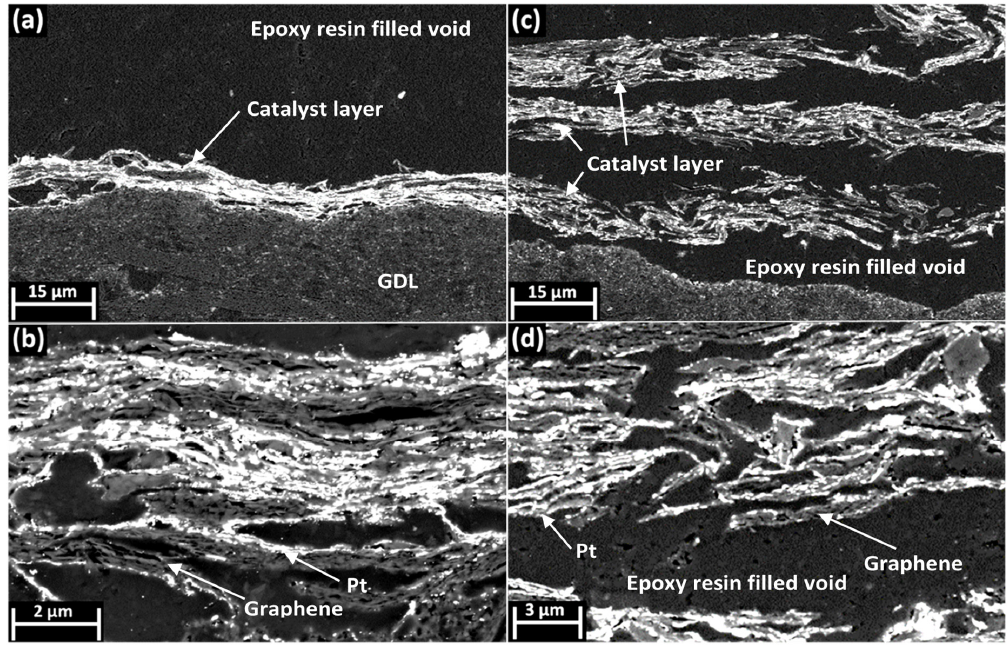
Figure 2. SEM images at two magnifications of graphene-based fuel cell CL cross-sections: ( a , b ) SEM images of graphene CLs prepared from a standard ink composition; ( c , d ) SEM images of graphene CLs prepared with urea added to the ink before spraying. The different components of the image can be distinguished via the contrast between them (darker, medium grey and brighter contrast are respectively the epoxy resin, graphene or ionomer and the Pt nanoparticles) and are labelled for ease of understanding. The epoxy resin-filled voids were formed as a result of the pore structure within the catalyst layer, and as such were representative of the size and distribution of these pores. Figure 3 shows the distribution of Pt and F across the catalyst layer measured via X- ray energy dispersive spectroscopy (EDS) analysis. The F elemental map shows that for both CLs the ionomer was evenly distributed between the layers of FLG, forming con- nected pathways across the CL and good contact with the Pt. However, as shown in Figure 3b, the CLs fabricated without urea possessed significant ionomer content, filling the spaces between the layers of restacked graphene. The presence of the Nafion ionomer trapped between the graphene sheets would further be expected to lead to increased O 2 diffusion limitations [5]. The MEA prepared with urea (Figure 3c,d) possessed more voids between ionomer filled regions while maintaining a highly connected ionomer network, this is expected to reduce overall O 2 mass transport resistances.